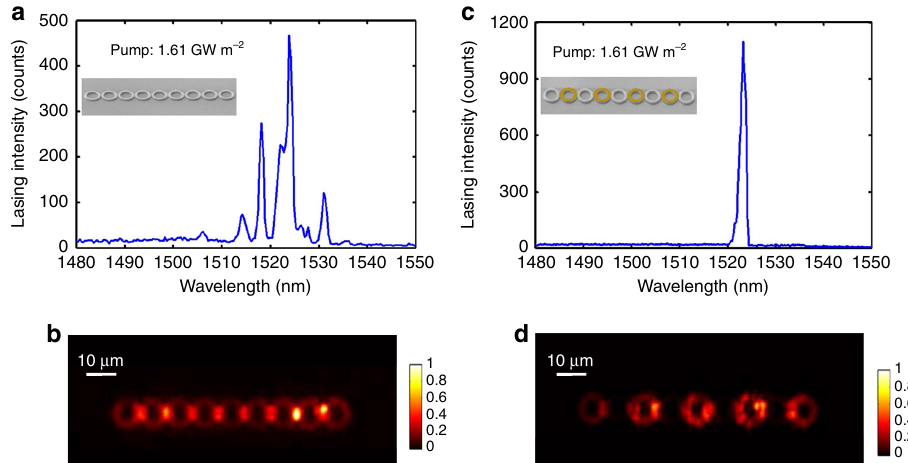
Fig. 3 Intrinsic single-supermode topological laser action. a Multimode lasing from an identically sized microlaser array as the topological microlaser, but without on-top Cr deposition on every second ring to introduce the distributed gain/loss pro fi le. b Measured lasing mode pro fi le of the topological microlaser without on-top Cr deposition. c Single-supermode lasing from the topological microlaser under the same pumping condition. d Measured lasing mode pro fi le of the topological microlaser with the distributed gain/loss pro fi le. The broad spectrum in a is due to mode competition between the transverse and longitudinal modes of the single-ring resonators, each of which forms its own collective state. In c , the distributed gain and loss judiciously spoils the quality factors of the strongly hybridised modes, topologically favoring only the zero mode centred around λ = 1523